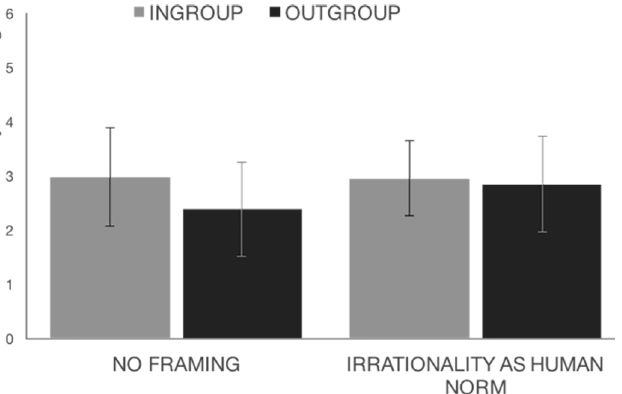
Figure 3. Evaluation of the target person in no framing and irrationality as human trait conditions as a function of the target person’s membership, the Polish sample in Study 2. Note. Error bars represent standard deviations ( SD s).